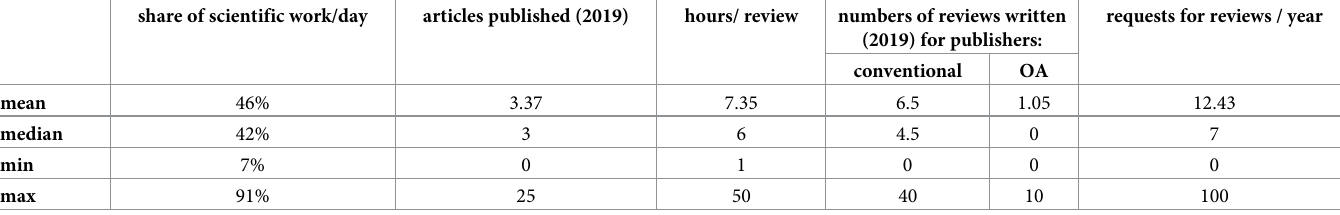
Table 3. Descriptive statistics for some selected key figures from the case study. share of scientific